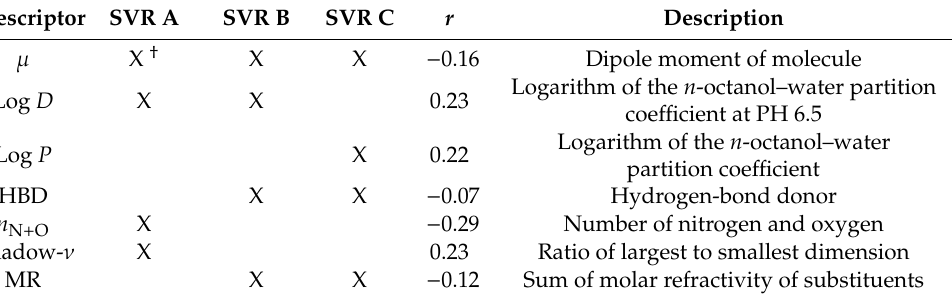
Table 1. Descriptors selected as the input of SVR models in the ensemble, the correlation coe ffi cient ( r ) with log P e ff , and their